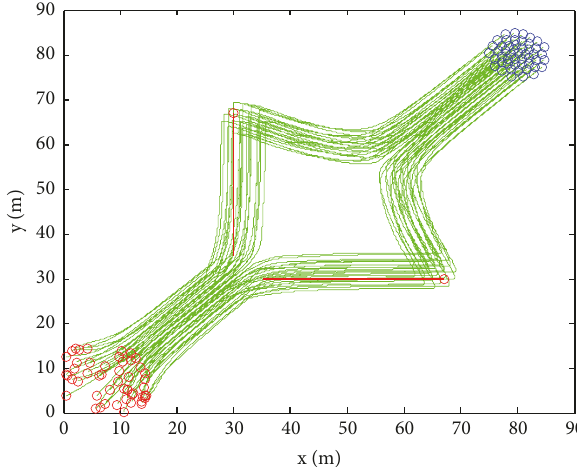
Figure 8: The reunion capability of the flocking system after